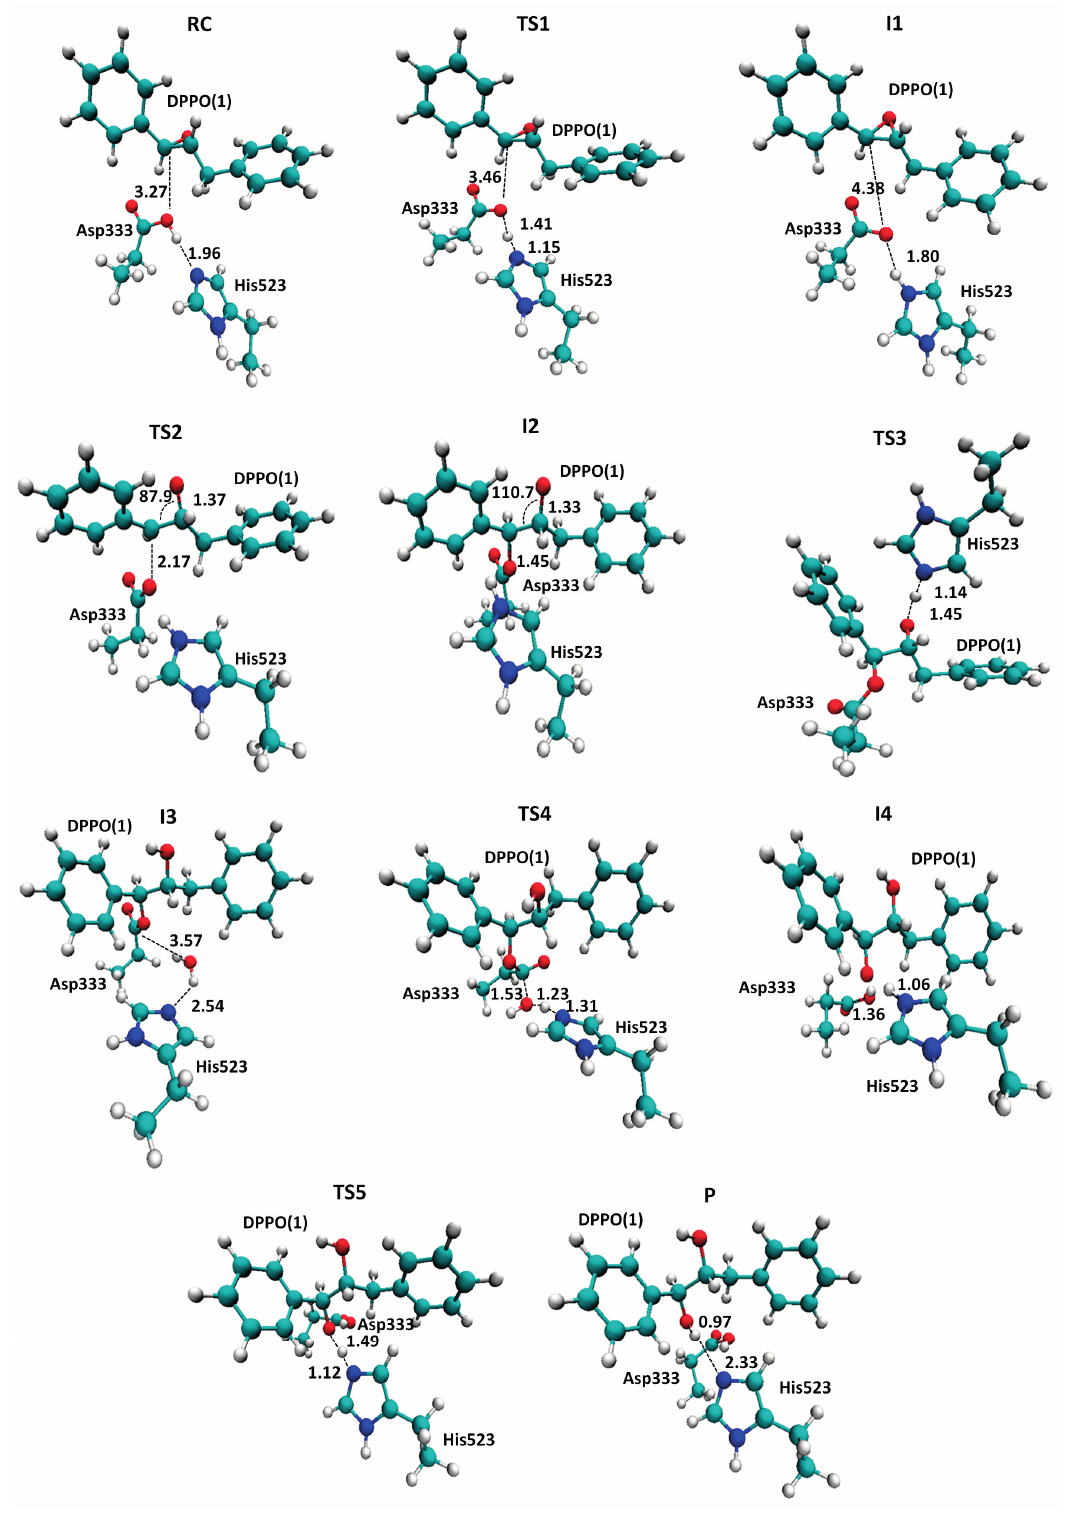
Figure 6. Localized structures for hydrolysis reaction of t-DPPO(1) catalyzed by sEH. Key inter-atomic distances are reported in Å. Tyr381 and Tyr465, forming the oxyanion hole, are not displayed for the purposes of